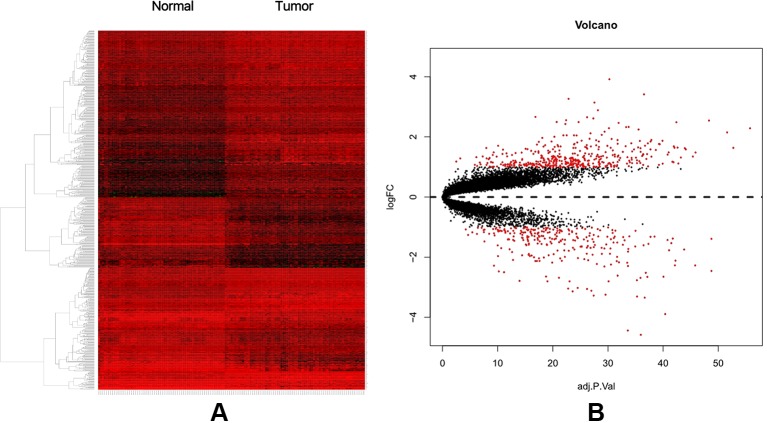

(A) Heat map of DEGs. (B) Volcano plot of genes detected in CRC. Red means upregulated and downregulated DEGs; black means no difference.